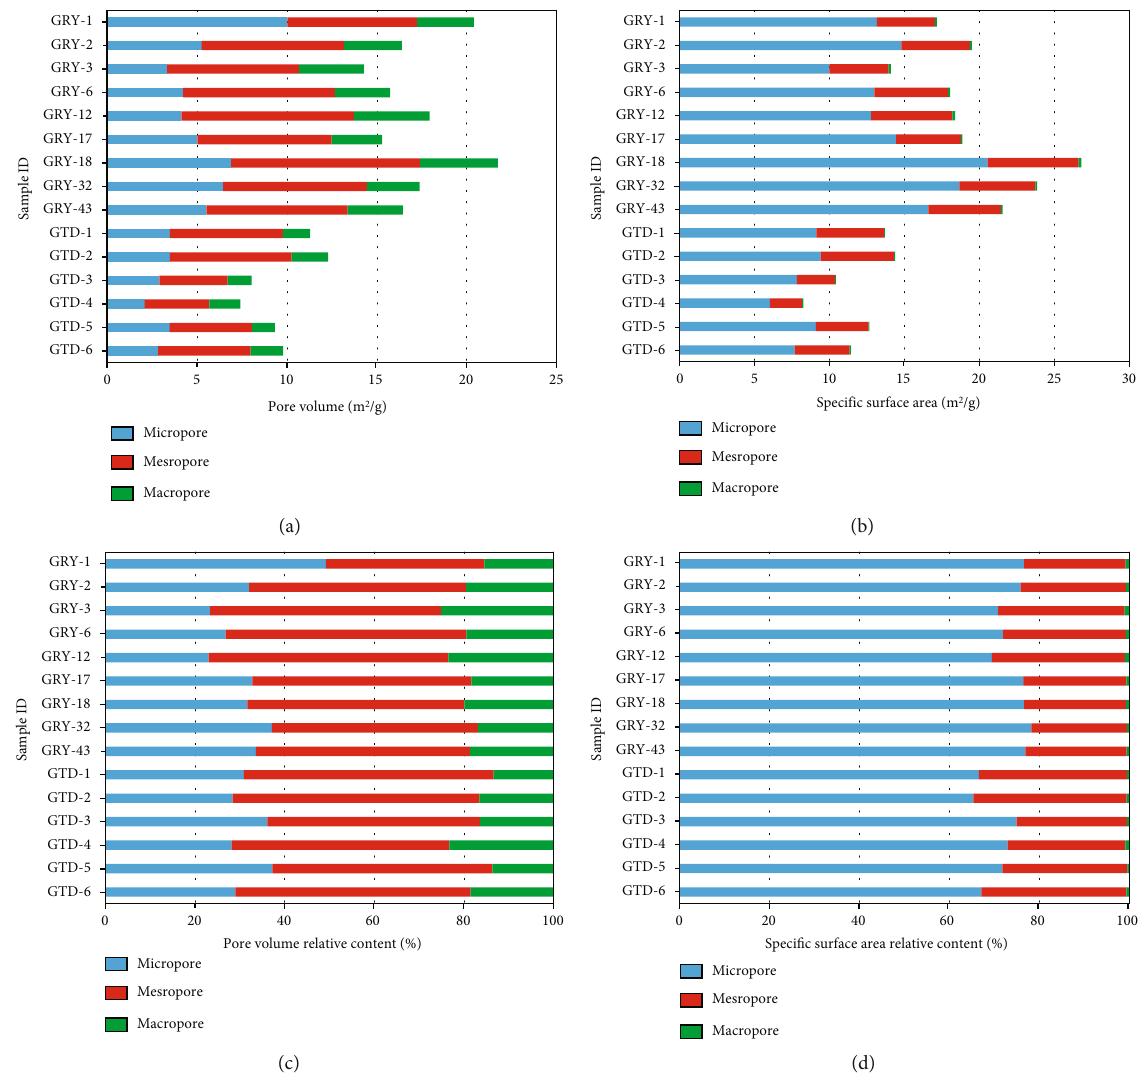
Figure 10: Pore volume and speci fi c surface area and their percentage distribution in Devonian shale (well GTD1) and Carboniferous shale (well